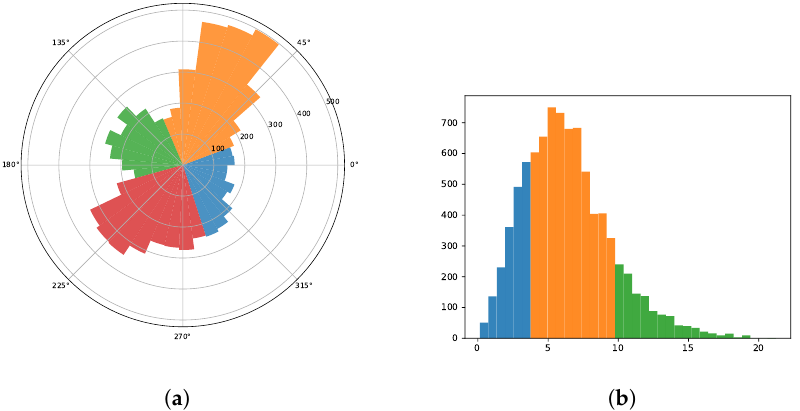
Figure 4. Histograms of wind. ( a ) Histogram of wind angles derived from NWP data for the year 2016 in Sotavento colored by task angle. ( b ) Histogram of wind velocity derived from NWP data for the year 2016 and measured in m/s in Sotavento colored by task